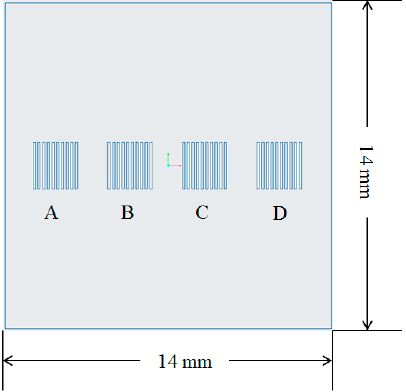
Figure 1. Design of the tooling insert and positioning of the microfeatures.